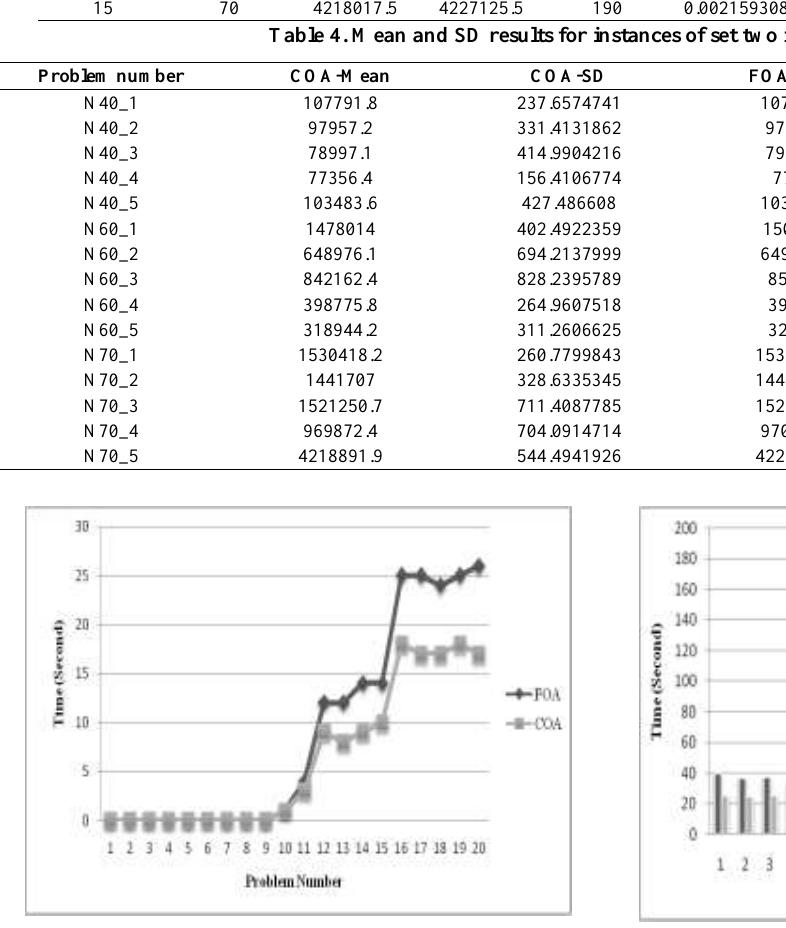
Figure 12. Comparison of computational times of two CO- Figure 13. Comparison of computational times of two CO- and FO-based algorithms for instances with number of and FO-based algorithms for instances with number of facilities less than 30. facilities more than